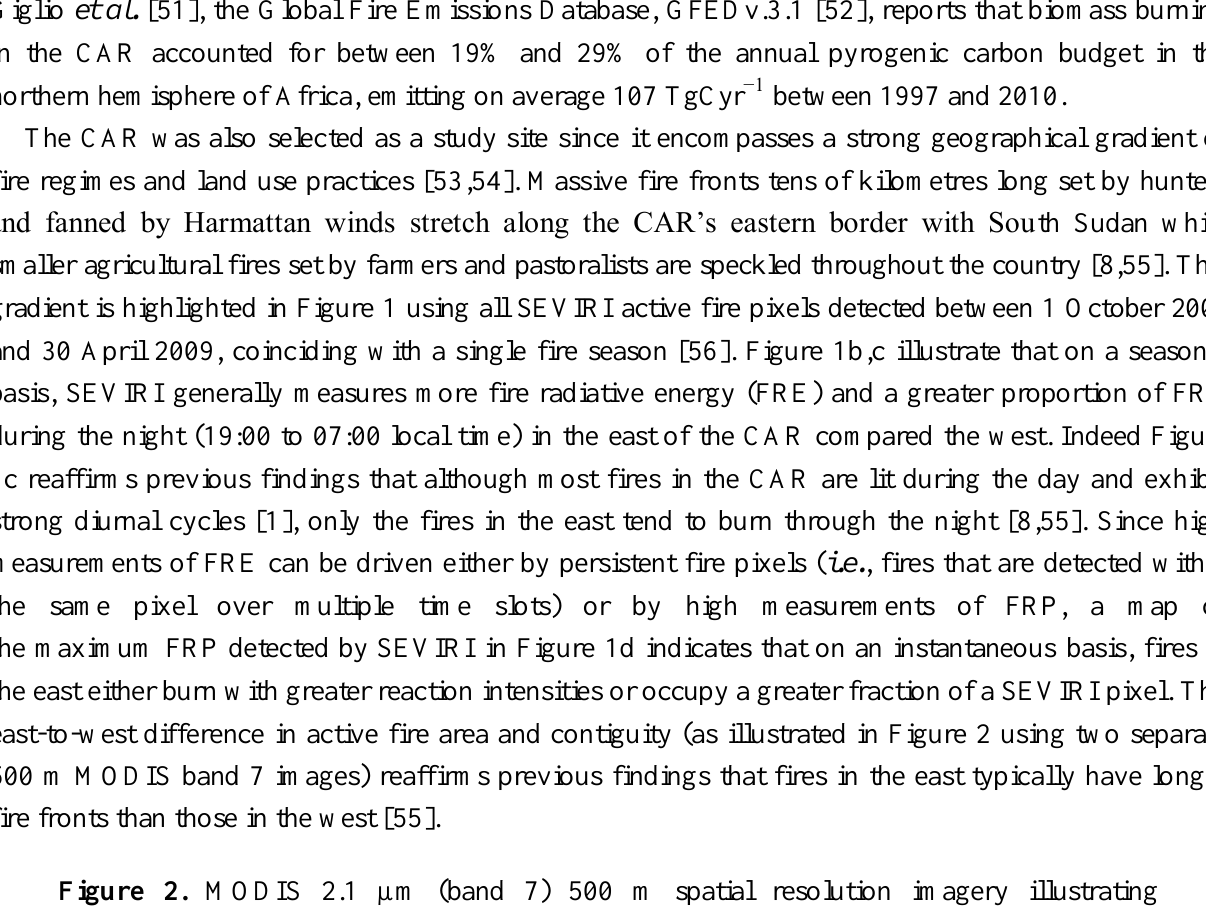
Figure 2. MODIS 2.1 µm (band 7) 500 m spatial resolution imagery illustrating differences in typical fire behavior between the west ( a ) and east ( b ) of the CAR. Whereas individual fires in ROI 3 (a) are predominantly contained within one or two MODIS 500 m spatial resolution pixels, fire fronts in ROI 1 (b) quite often extend tens of